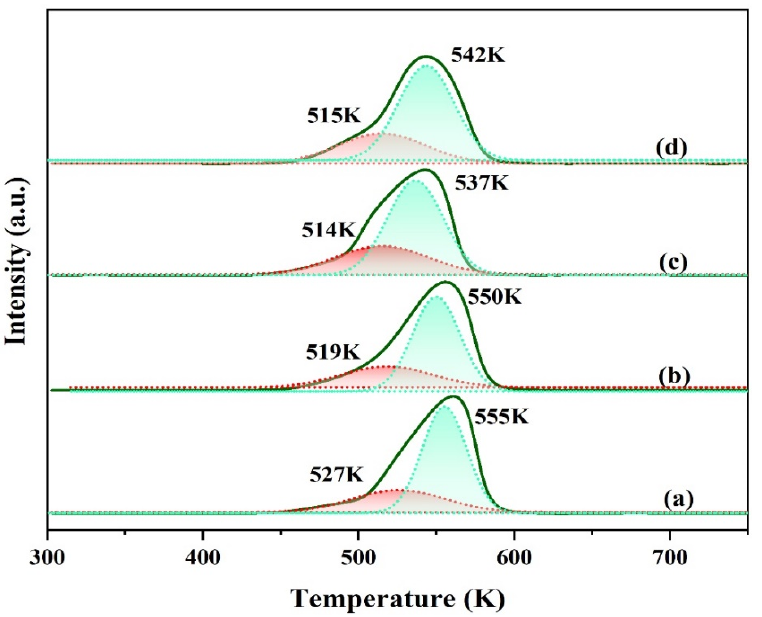
Figure 4. H 2 -TPR profiles of the calcined catalysts. ( a ) CZA, ( b ) CZAGa-1, ( c ) CZAGa-2, ( d ) CZAGa-3.